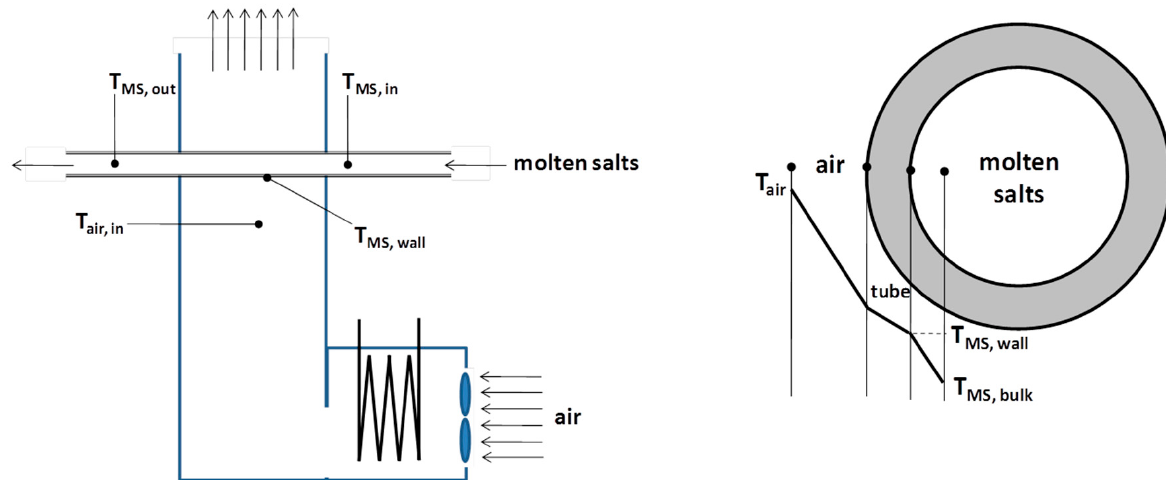
Figure 1. General scheme of the MSH system.